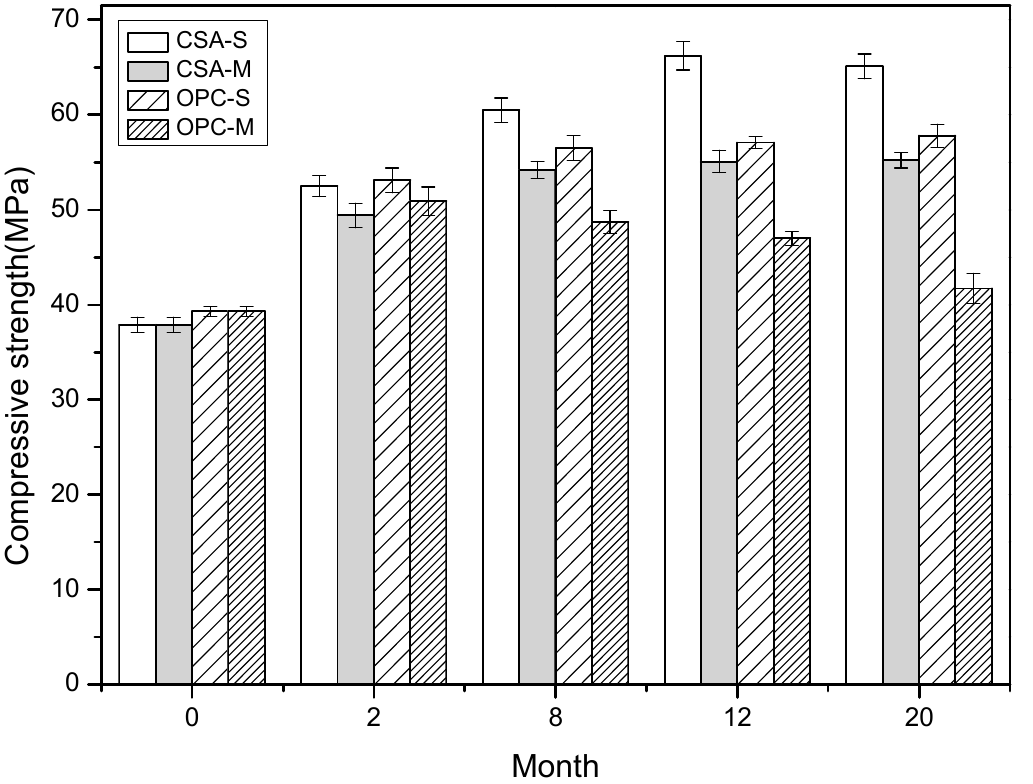
Figure 3. Effects of marine tidal environment on the compressive strength of CSA and OPC cement (“S” and “M” represent standard curing and marine tidal environments).